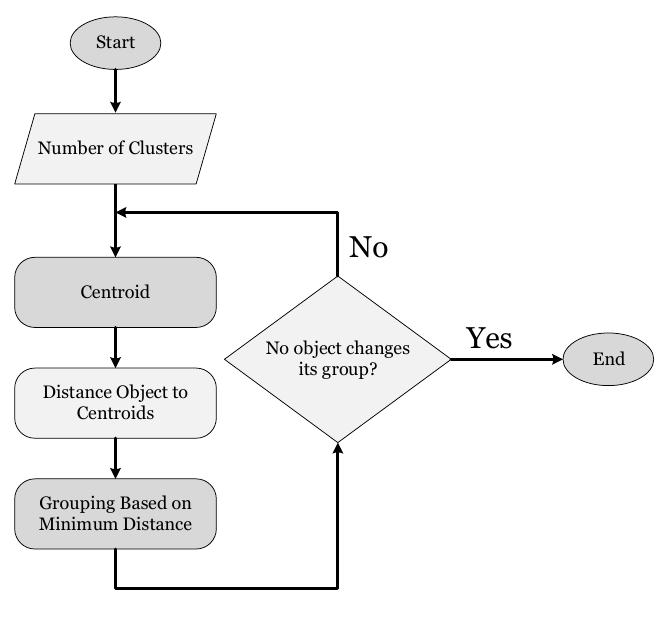
Figure 15. Illustration of k-means clustering. Table 4. Taxonomy of ML based methods for IoT systems